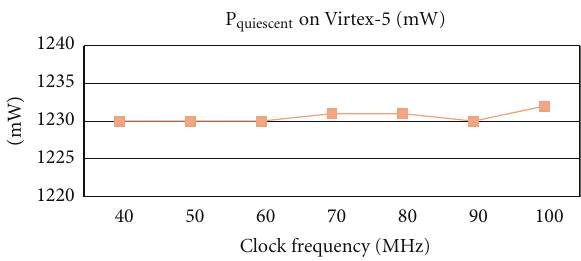
Figure 18: Impact of the clock frequency to the static power consumption of a uniprocessor design on a V5LX110T.